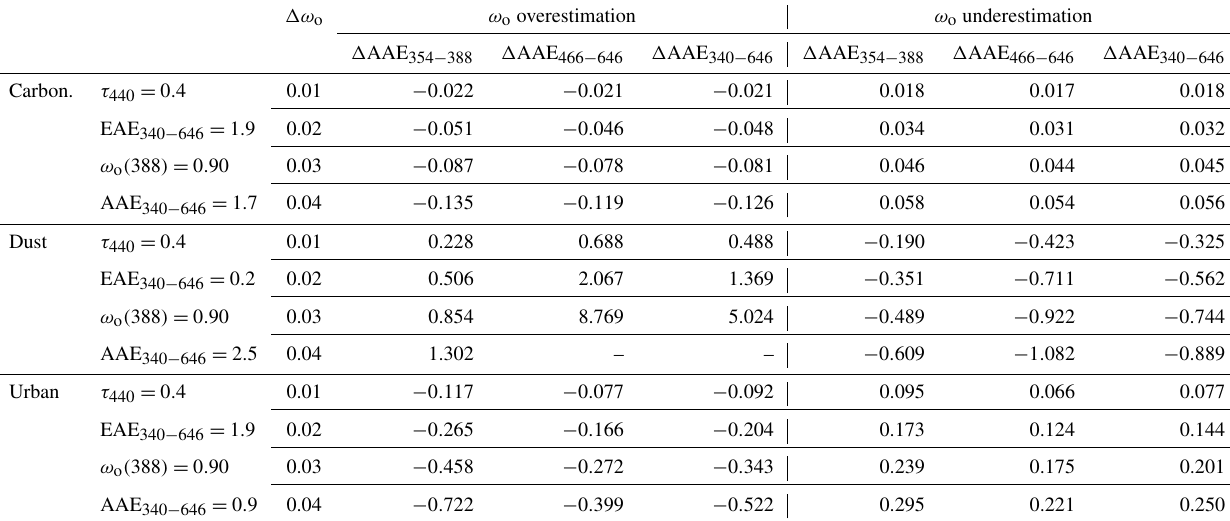
Table 3. Theoretical uncertainties in the computation of absorption Ångström exponent.